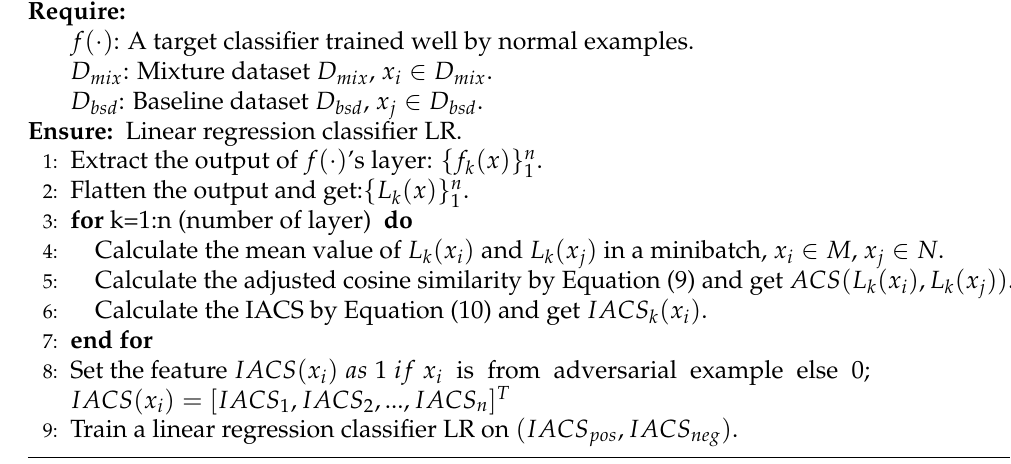
Algorithm 1 Adversarial detection algorithm based on